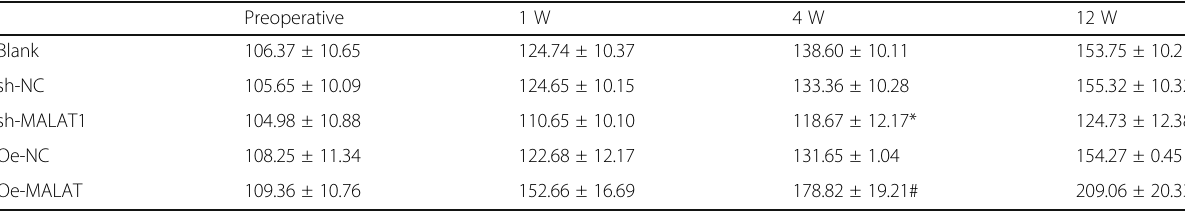
Table 3 Changes of blood pressure (mmHg) of rats in each group Preoperative